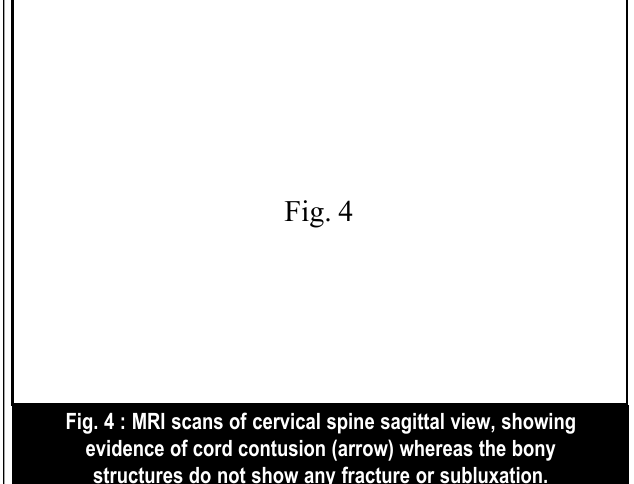
Fig. 4 : MRI scans of cervical spine sagittal view, showing evidence of cord contusion (arrow) whereas the bony structures do not show any fracture or